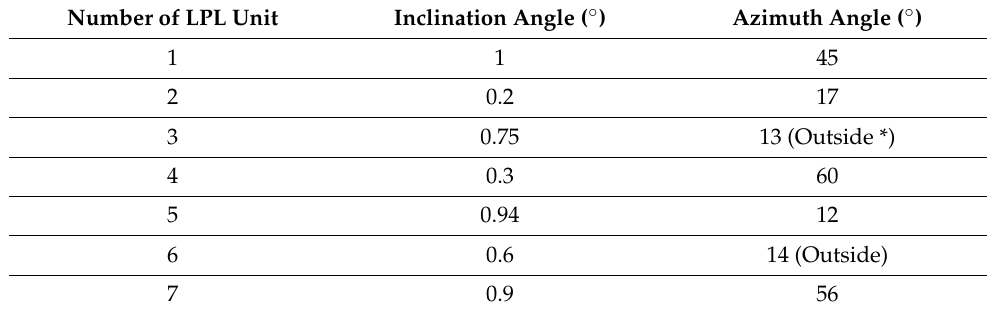
Table 6. Those specified angle errors of the seven LPL units for the automatic identification verifica- tion